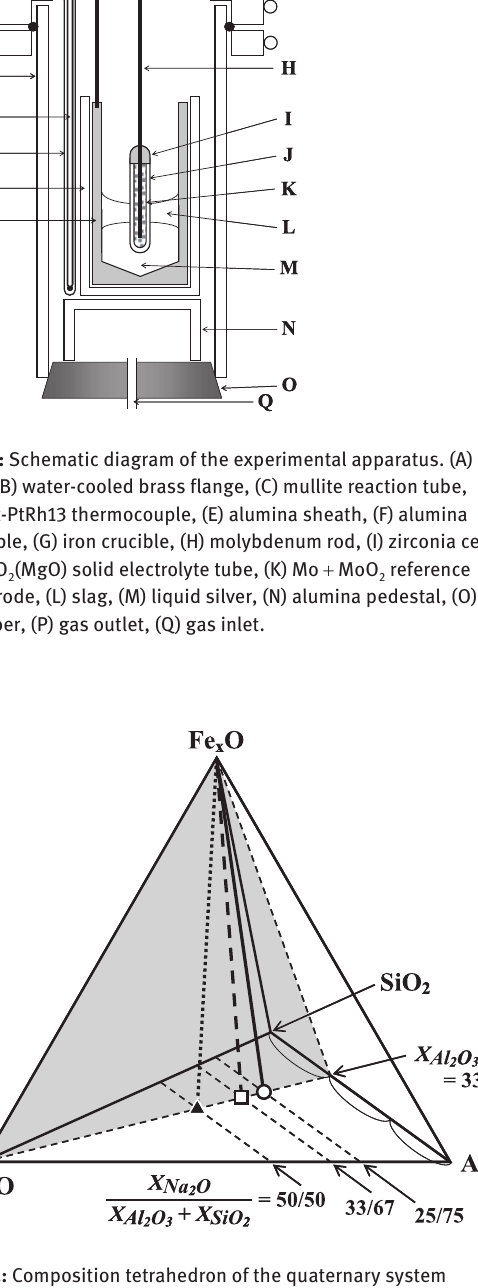
Fig. 2: Composition tetrahedron of the quaternary system Na O-Al O -SiO -Fe 2 2 3 2 x